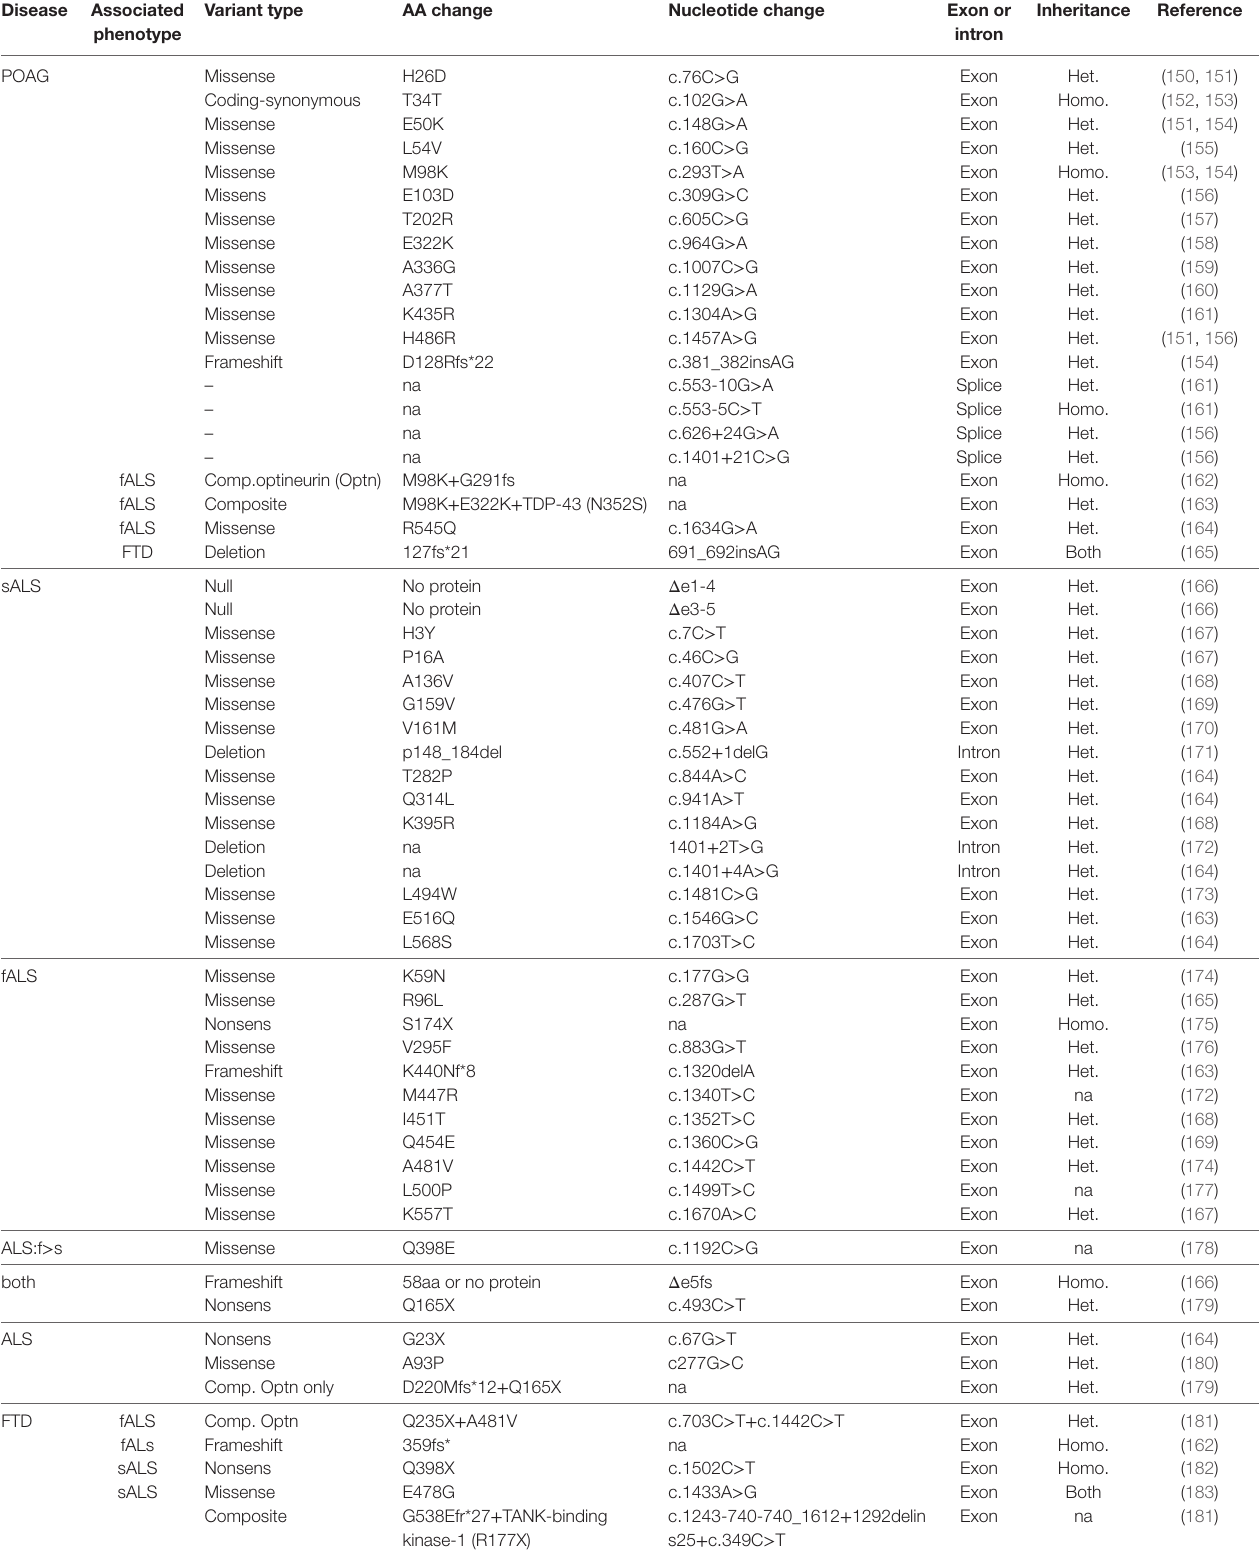
TABLe 1 | Gene mutations and nucleotide variations associated with open-angle glaucoma and amyotrophic lateral sclerosis (ALS). Disease Associated variant phenotype